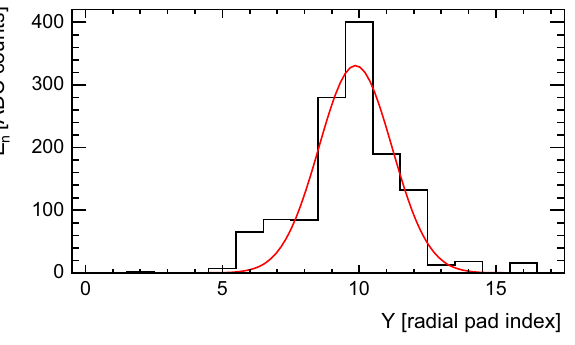
the Gaussian fit, are shown in Fig. 22. Since the telescope position resolution is much better than that of the